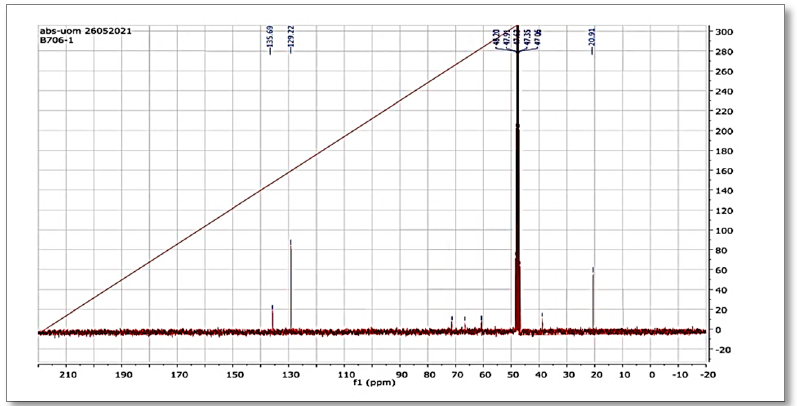
Figure 14. 13 C NMR after Pseudomonas aeruginosa degradation.